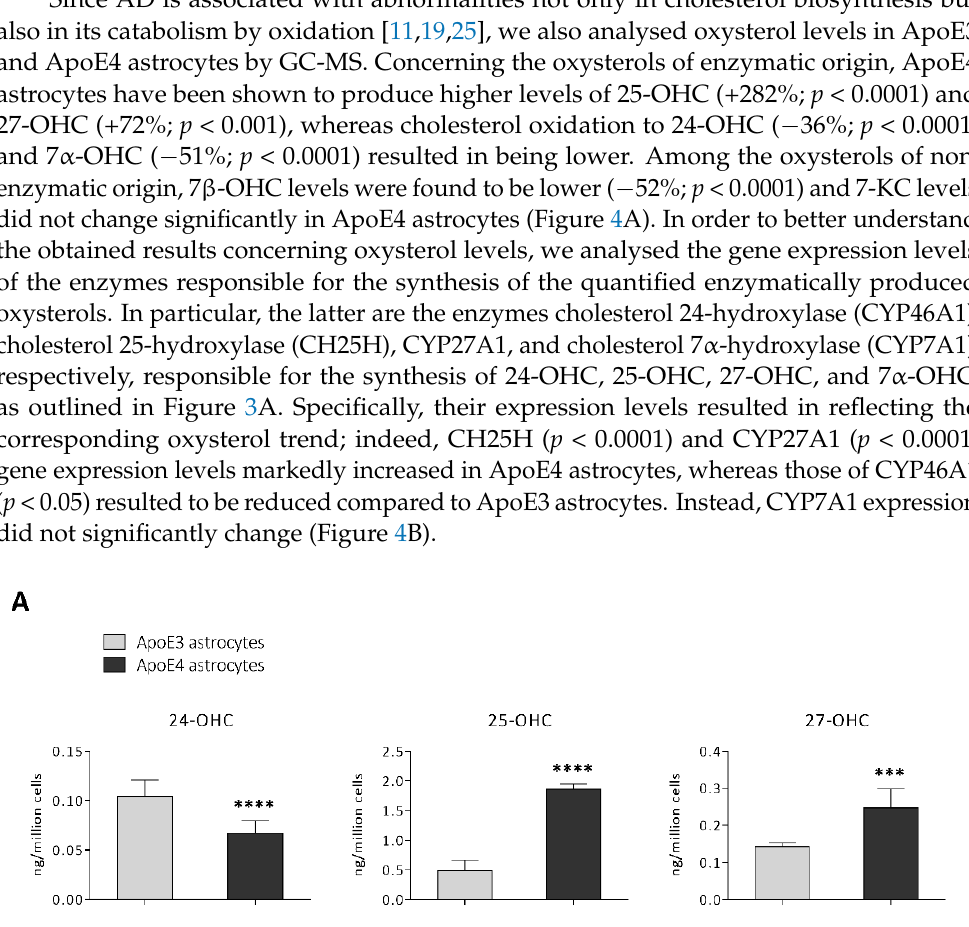
Figure 4. Quantification of oxysterols and gene expression analysis of the enzymes involved in cho- lesterol oxidation. ( A ) The amount of the oxysterols 24-hydroxycholesterol (24-OHC), 25-hydroxy- cholesterol (25-OHC), 27-hydroxycholesterol (27-OHC), 7  -hydroxycholesterol (7  -OHC), 7  -hy- droxycholesterol (7  -OHC), and 7-ketocholesterol (7-KC) were quantified by gas chromatography- mass spectrometry (GC-MS) in ApoE3 and ApoE4 immortalized mouse astrocytes. Data are ex- pressed as mean values ± SD of three different experiments ( n = 9 , Student’s t -test). **** p < 0.0001, *** p < 0.001 vs. ApoE3 astrocytes. ( B ) Gene expression levels of the enzymes cholesterol 24-hydrox- ylase (CYP46A1), cholesterol 25-hydroxylase (CH25H), cholesterol 27-hydroxylase (CYP27A1), and cholesterol 7  -hydroxylase (CYP7A1) were analysed in ApoE3 and ApoE4 immortalized mouse as- trocytes. Gene expression results were normalized to GAPDH expression levels. Data are shown either as Log 2 (gene/GAPDH) or as Log 2 (FC). Data are expressed as mean values ± SD of three dif- ferent experiments ( n = 8 , Student’s t -test). **** p < 0.0001, * p < 0.05 vs. ApoE3 astrocytes.